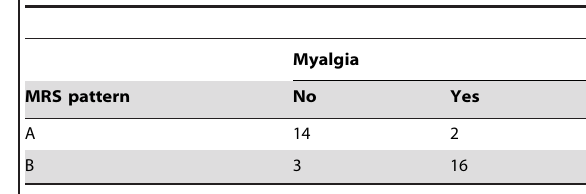
Table 3. Distribution table for myalgia in finger extensor muscles vs. MRS pattern detection on a forearm